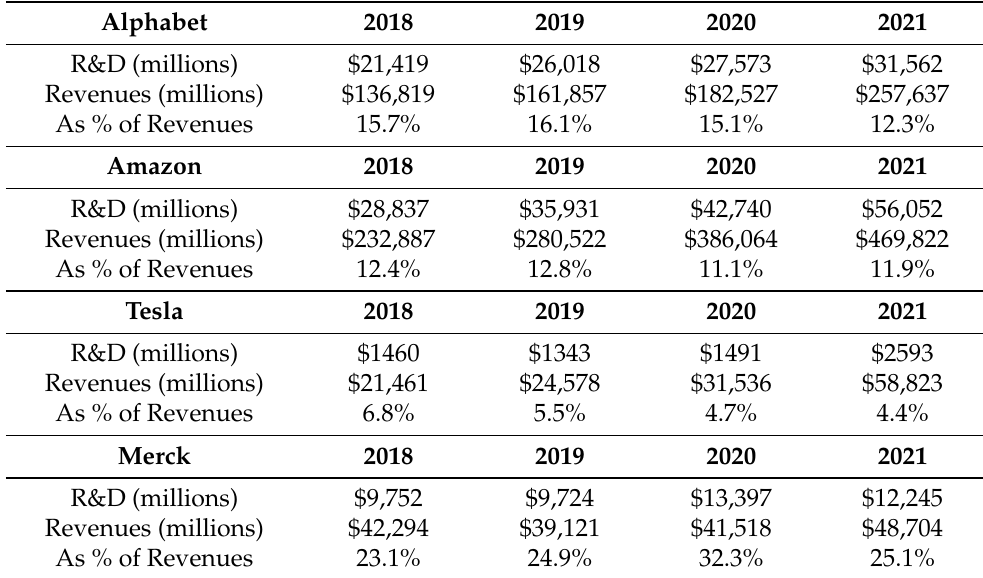
Table 1. R&D spending by Alphabet, Amazon, Tesla and Merck during